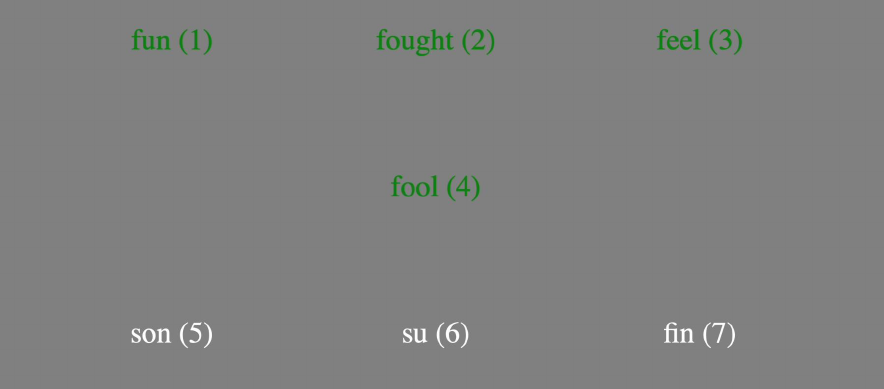
Figure 3. Answer Choices for the Bilingual Vowel Categorization Task. A stimulus sound was played and participant chose a carrier word by pressing a corresponding number key.